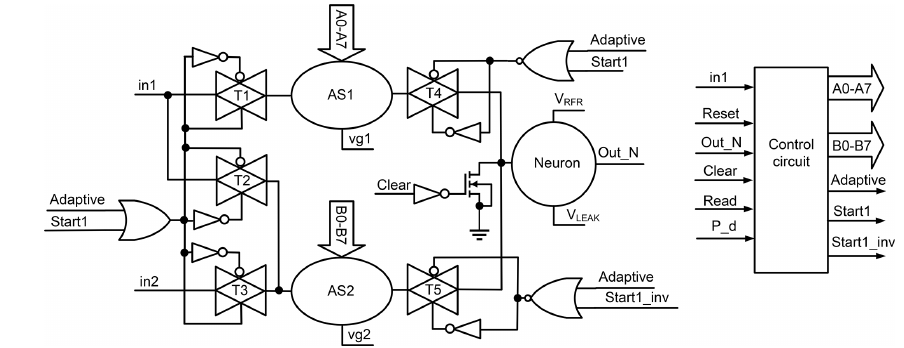
Figure 4. The proposed adaptive coincidence detection (ACD) scheme is implemented with two adaptive synapses (ASs) and one neuron. The control circuit implements the self-adaptive method for the weights of the synapses. The transmission gates T1–T5 are used to connect and disconnect the ASs during the adaptation of their